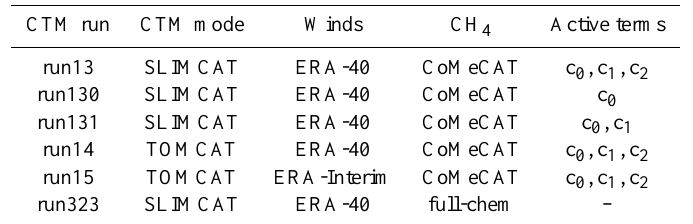
Table 1. TOMCAT/SLIMCAT CTM runs performed with the CoMeCAT scheme and full-chemistry run323. For each run, the CTM mode ( σ - θ SLIMCAT or σ -p TOMCAT) and the winds used to drive the simulation are indicated. For the runs using the CoMeCAT scheme, the terms of the parameterisation that have been active for the particular run are also included. Winds for the runs with CoMeCAT correspond to year 2000.